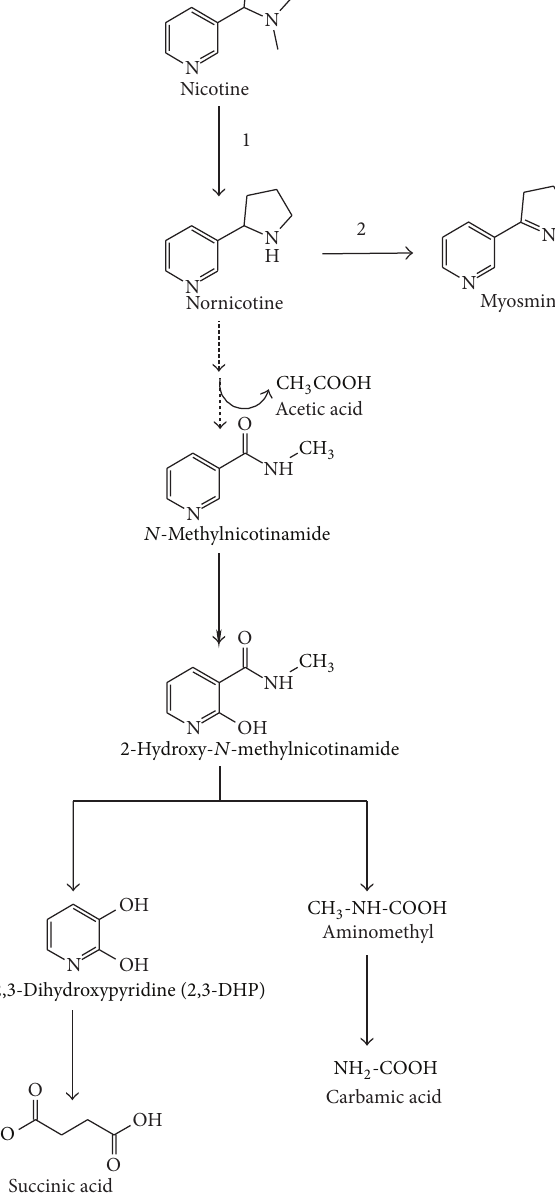
Figure 5: Demethylation pathway of nicotine degradation by